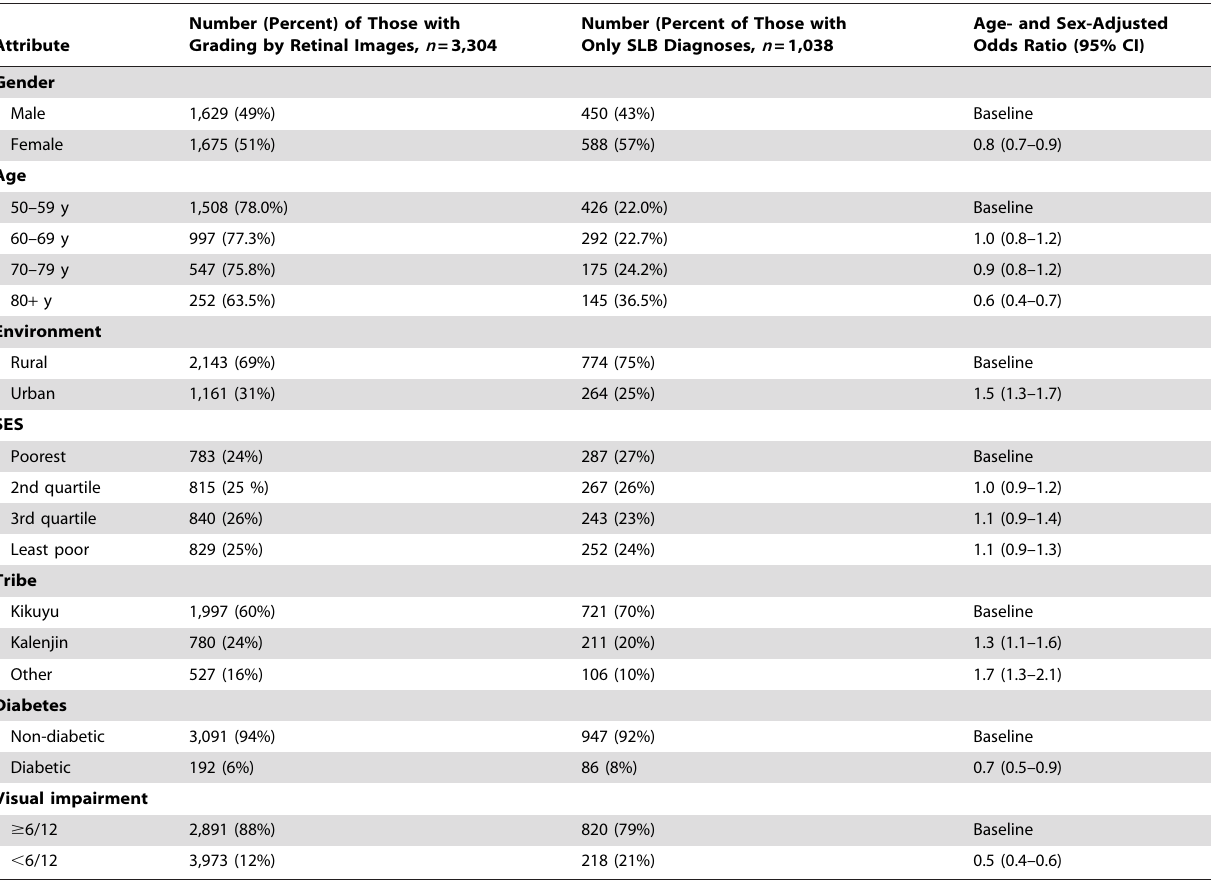
Table 1. Demographic characteristics of study participants ( n = 4,381).